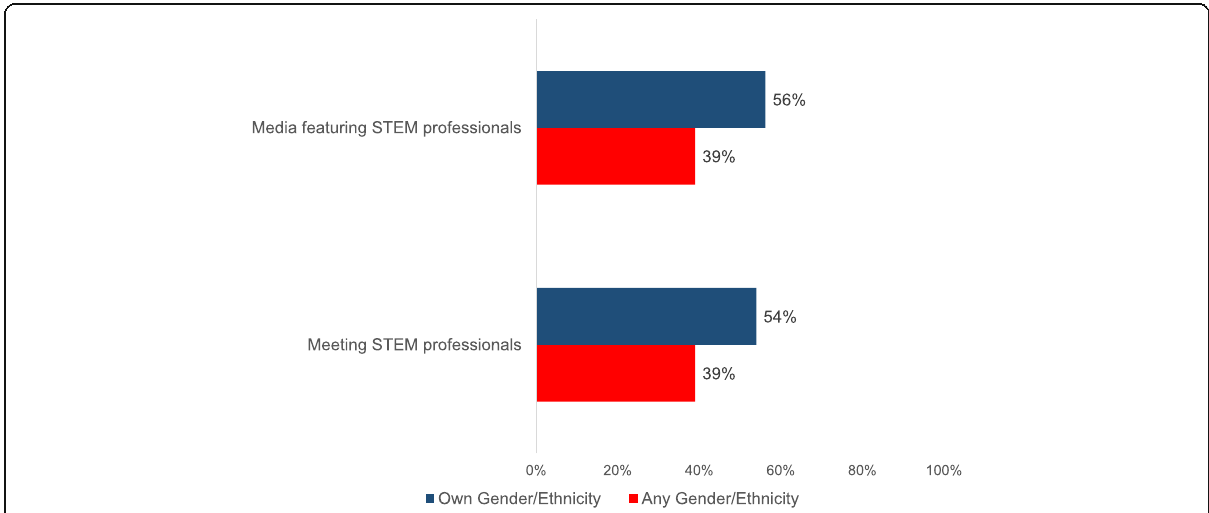
Fig. 2 Preferences regarding gender- and ethnicity-matched mentors. What do you think would encourage more people of your gender and ethnicity to pursue STEM careers? The majority of respondents (54%) believed that exposure to a STEM professional of their own gender and ethnicity would encourage them to pursue STEM. A similar percentage (56%) believed that media exposure to gender- and